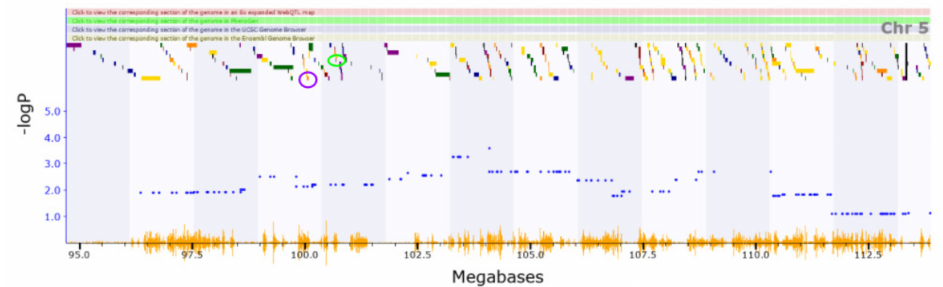
Figure 3. A QTL corresponding with locomotion in response to cocaine has ten genes with cis-eQTLs for Trait ID BXD_11487. A QTL containing Enoph1 shown in the purple circle (100.062 Mb) has been implicated in previous research for its role in stress reactivity. Coq2 shown in the green circle (100.654 Mb) has been investigated for its contribution to neurodegenerative disorders. Although these two genes are great candidates for genes of interest, these aren’t the only applicable. Other relevant genes in this section have not been reported yet by other studies.